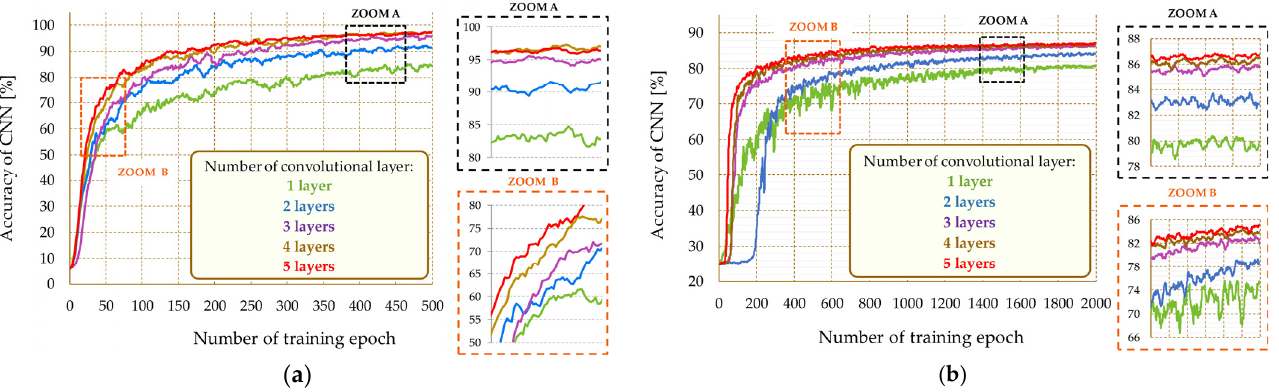
Figure 5 . Influence of the number of convolutional layers on the precision of the diagnostic sys- tem—learning curves: ( a ) induction motor; ( b ) PMSM. learning curves: ( a ) induction motor; ( b ) PMSM.